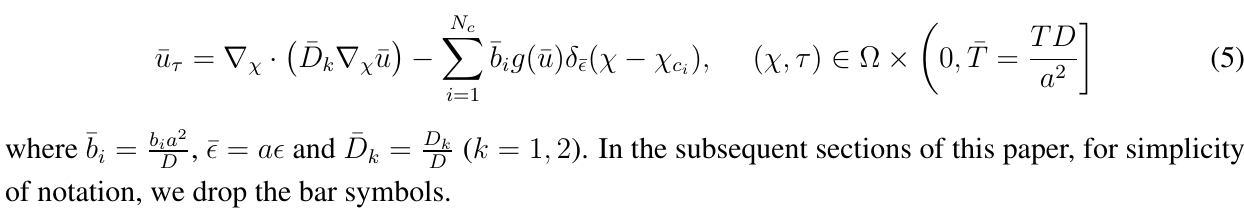
Figure 5. Numerical treatment of cellular effects in the hybrid discrete model. ( A ) High order quadrature with 37 points and based on a thirteenth-order Gaussian quadra- ture rule, is used to adequately resolve the effects of the cell supported δ element integrals; ( B ) Illustration of a typical uniform mesh taken from a portion of the subdomain, Ω 2